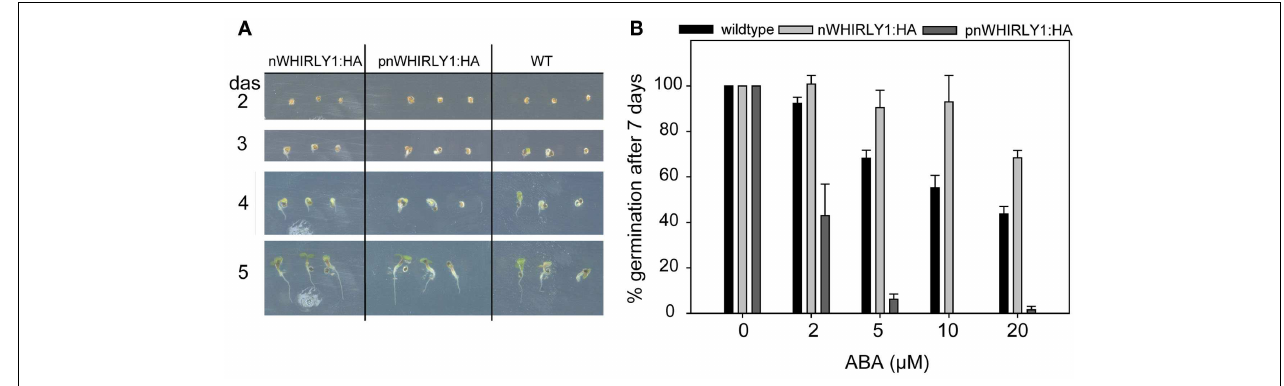
of ABA inhibition of germination.The percentage of seeds showing radicle emergence was scored after 7days of growth at 21˚C in a 16-h light/dark regime.Values are the means ± SEM obtained from at least three independent experiments with 20–50 seeds each.The averaged percentage of germinated seeds in the control experiments without ABA was set to 100% and used as a reference to calculate the percentage of germination in the assays performed in the presence of